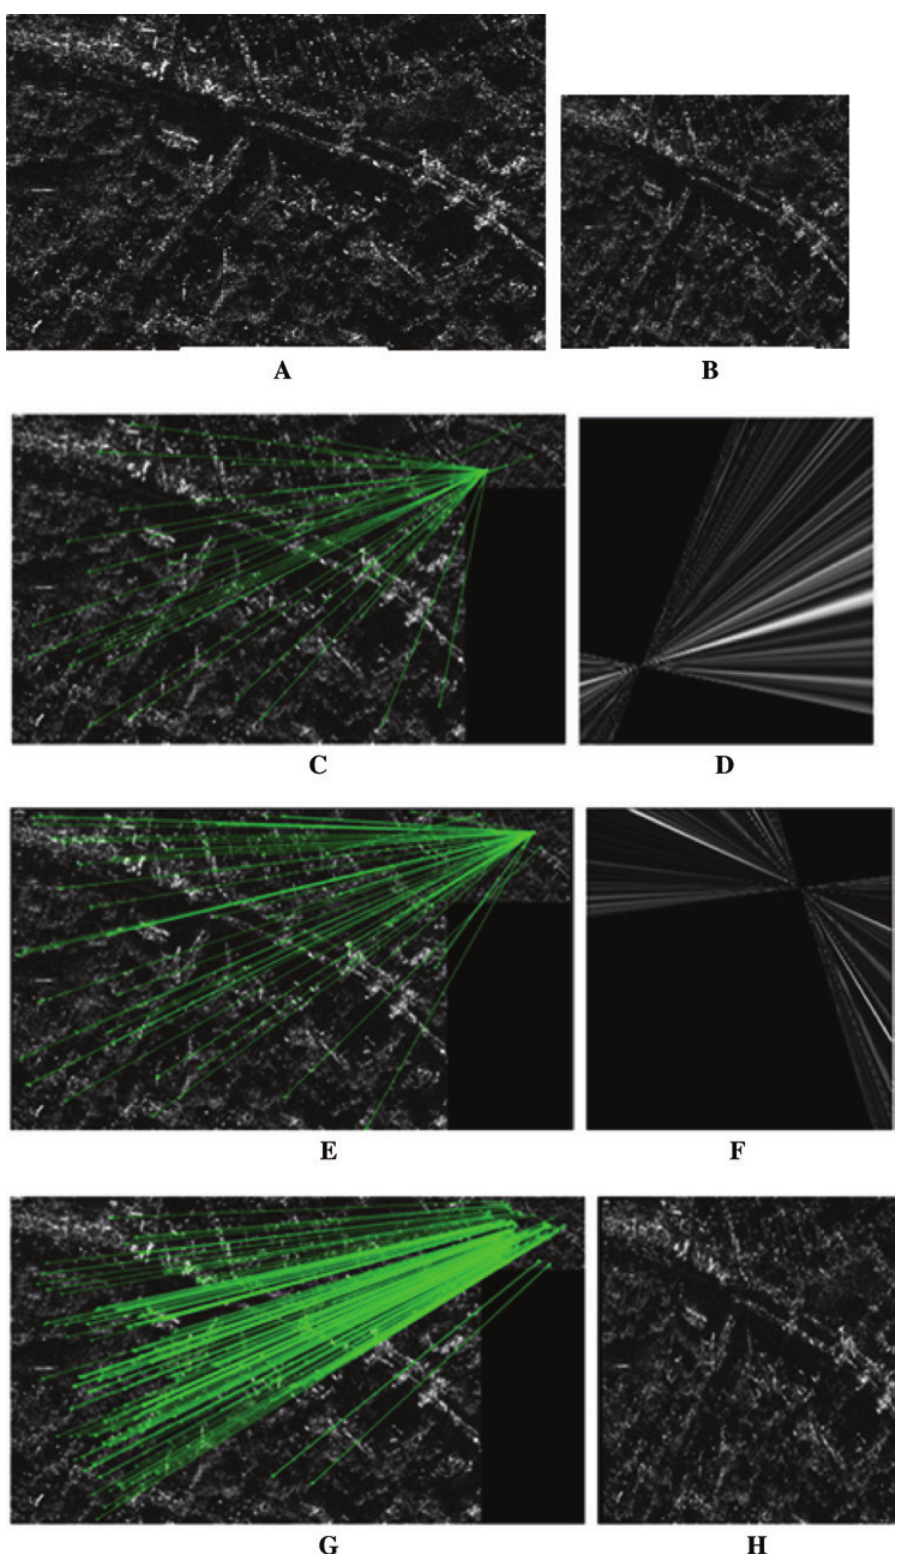
Figure 9: Dataset 2. (A) Dataset 2 – source SAR image; (B) dataset 2 – scale deformed target image; (C, E, G) number of correspondences obtained using FIA, ASIFT, and AIAVS; and (D, F, H) output aligned images using FIA, ASIFT, and